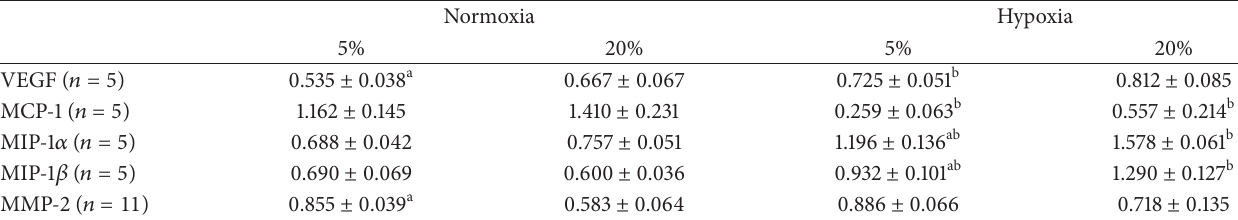
Table 3: Normalized relative expression of mRNA for paracrine